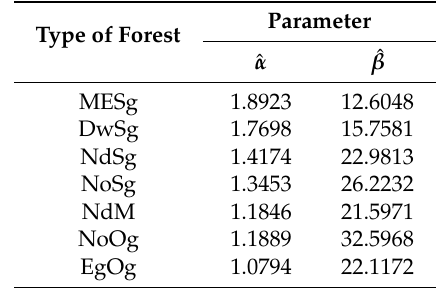
Table A1. Estimated parameters of the Weibull function (Equation (A1)) by type of forest.